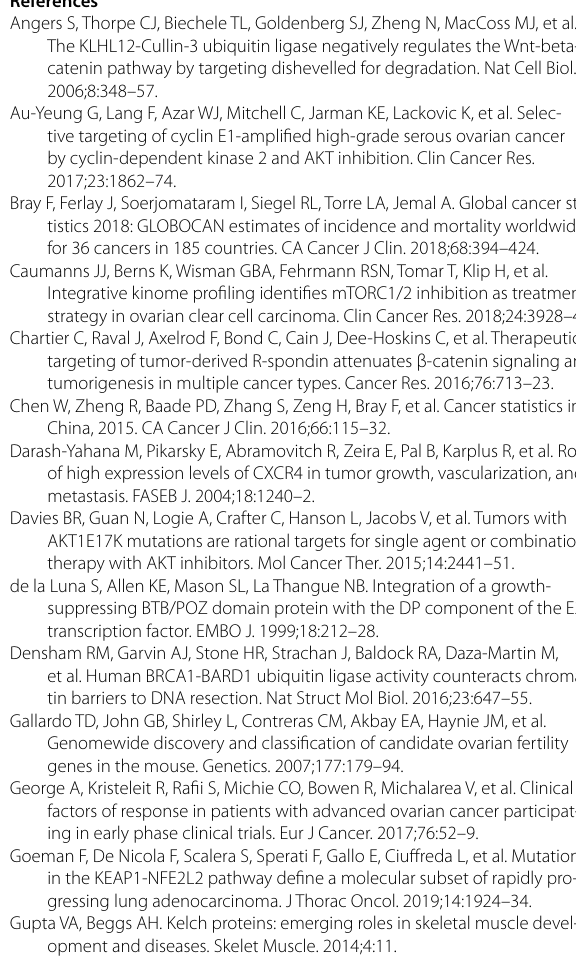
Figure 4: KBTBD8 knockdown decreased the overall ubiquitination level in A2780 EOC cells. A‑C related to Fig. 6d and e, three repeats all showed that KBTBD8 knockdown decreased the overall ubiquitination level in A2780 EOC cells. Figure 5: KBTBD8 knockdown suppressed tumor forma‑ tion in vivo in HO8910 cell xenograft model. A–C In vivo tumor formation assay in HO8910 cell xenograft model. Both tumor volume (tumor volume at 21d, CTR vs. K8‑KD, 490.4 mm 3 vs. 138.2 mm 3 ) and weight (tumor weight at 21d, CTR vs. K8‑KD, 0.5777 vs. 0.1451) were significantly